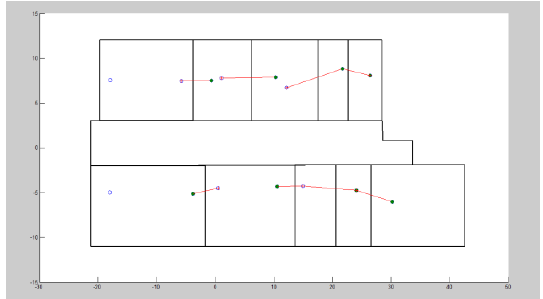
Figure 6. Test case 1 where surveying control points are represented as colored points and connection between dual nodes as red lines.